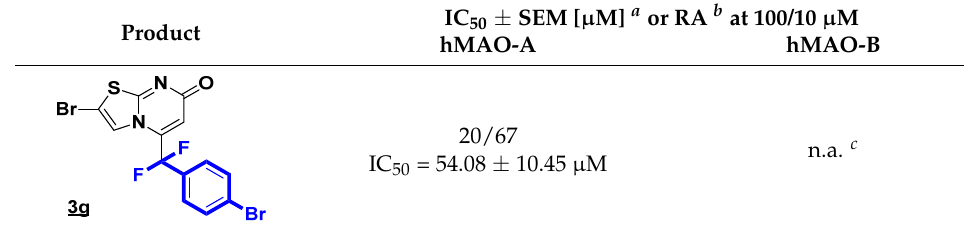
Table 2. In vitro hMAO inhibitors potencies of compound 3g .